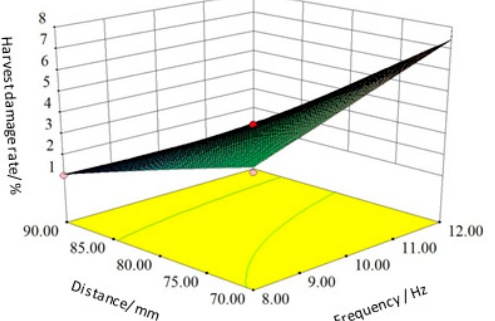
Figure 7. Y 3 = (0, B , C ). Response surfaces of harvesting knife frequency and distance on harvest damage rate.